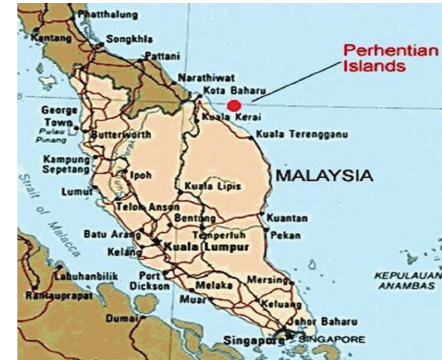
Figure 17: Location of target site (Perhentian Island) (modified from